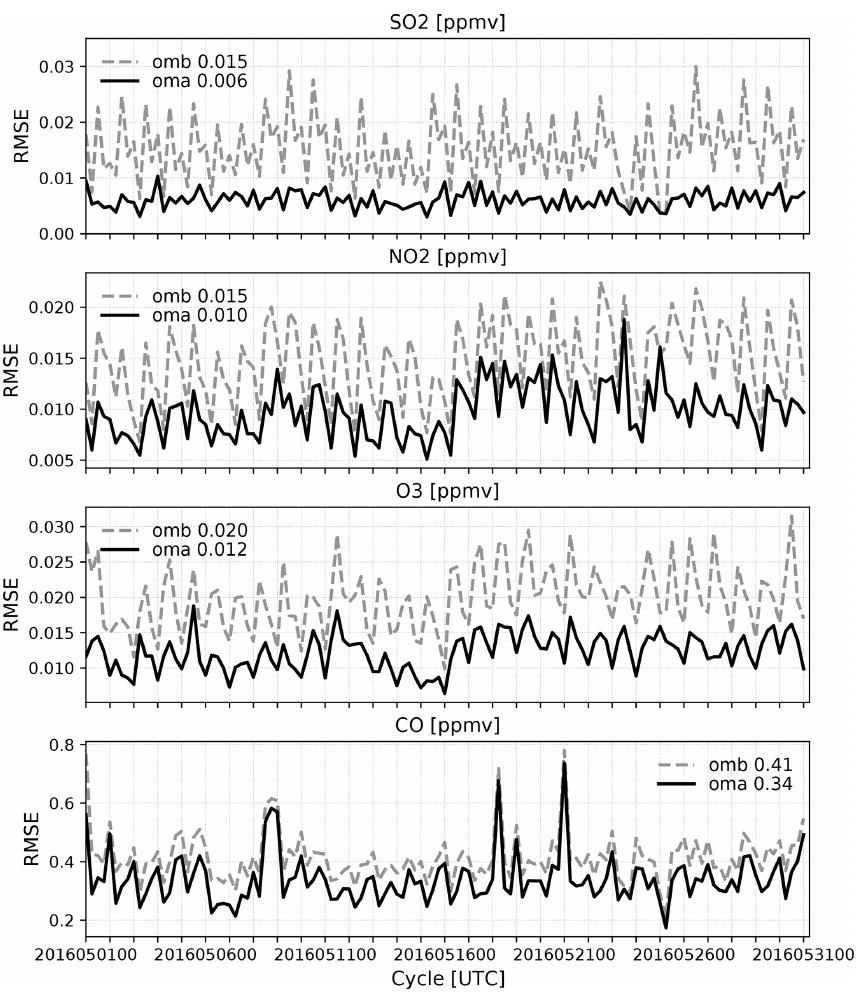
Figure 7. Same as Fig. 6 but for gas